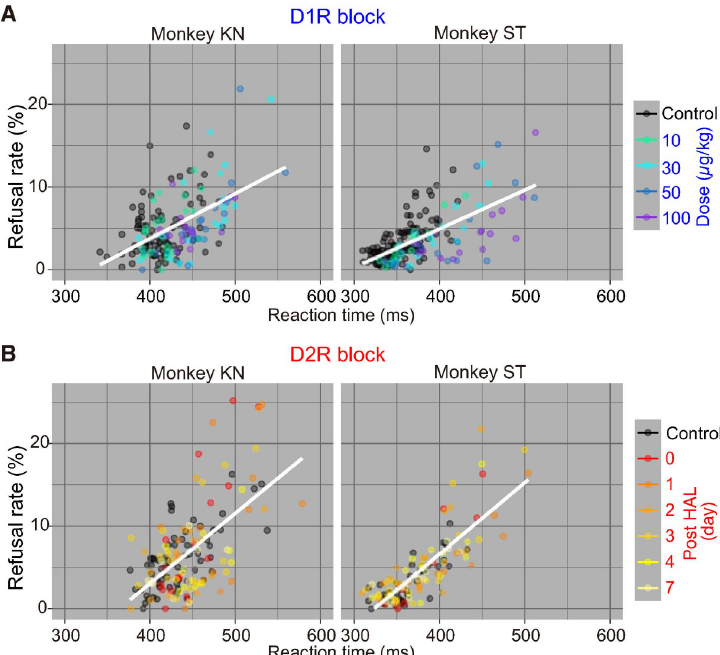
Fig 4. Relationship between refusal rate and RT in reward-size task. (A) Relationship between refusal rate and average RT for each reward size in session by session for D 1 R blocking in monkeys KN and ST. Colors indicate treatment condition. (B) Same as A, but for D 2 R blocking. Note that a simple linear regression (white line, model #1 in S2 Table) was selected as the best-fit model to explain the data. The data underlying this figure can be found on the following public repository: https://github.com/minamimoto-lab/2021-Hori-DAR. D 1 R, D 1 -like receptor; D 2 R, D 2 -like receptor; RT, reaction